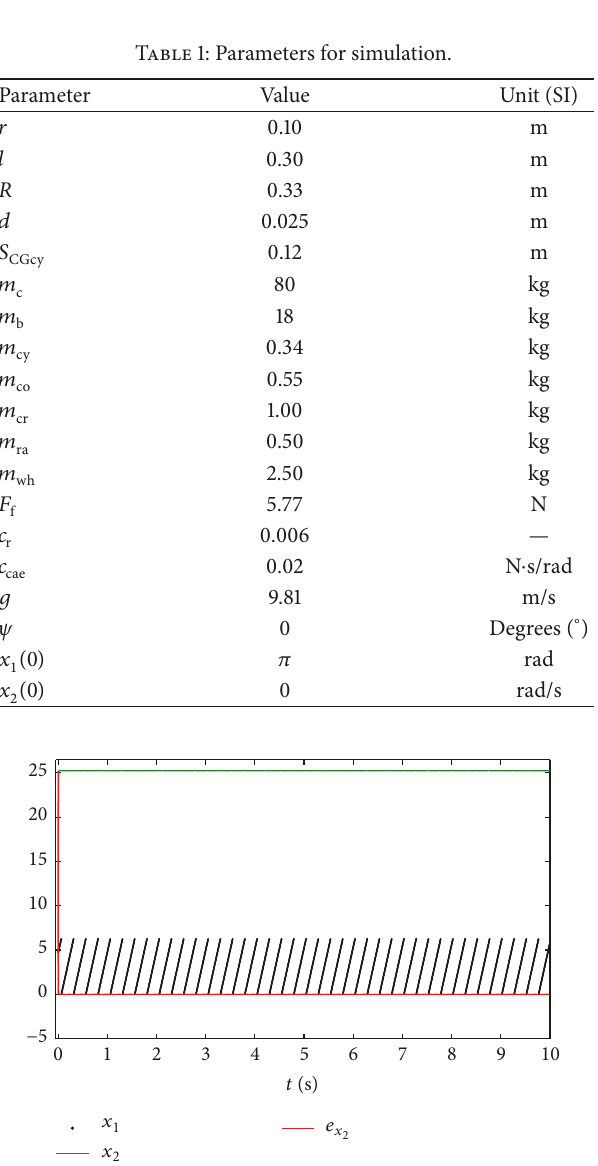
Figure 3: Double-cylinder with SDRE control by position and constant velocity ( 𝑥 2∗ = 25.245 rad/s = 30